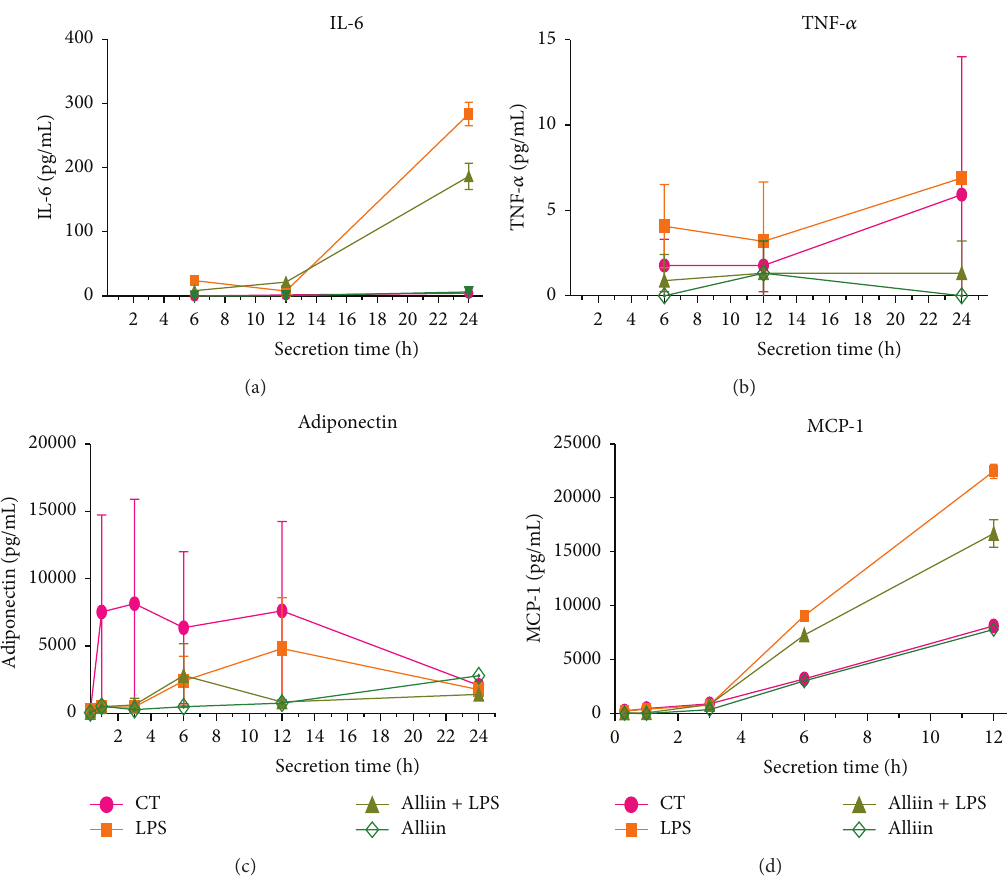
Figure 2: Protein expression levels of proinflammatory and anti-inflammatory proteins secreted by 3T3-L1 adipocytes. Cells were incubated with 0.1mM alliin for 24 h and exposed to 100ng/mL of lipopolysaccharides (LPS) for 1h. Cytokine and protein concentration in cell culture supernatants for 30min, 1, 3, 6, 12, and 24 h after LPS exposure were determined by Luminex technology. Values are expressed in pg/mL of supernatant. Results are mean ± standard deviations (SD) of three independent experiments. ∗ 𝑃 ≤ 0.05 ; ∗∗ 𝑃 ≤ 0.01 ; ∗∗∗ 𝑃 ≤ 0.001 .